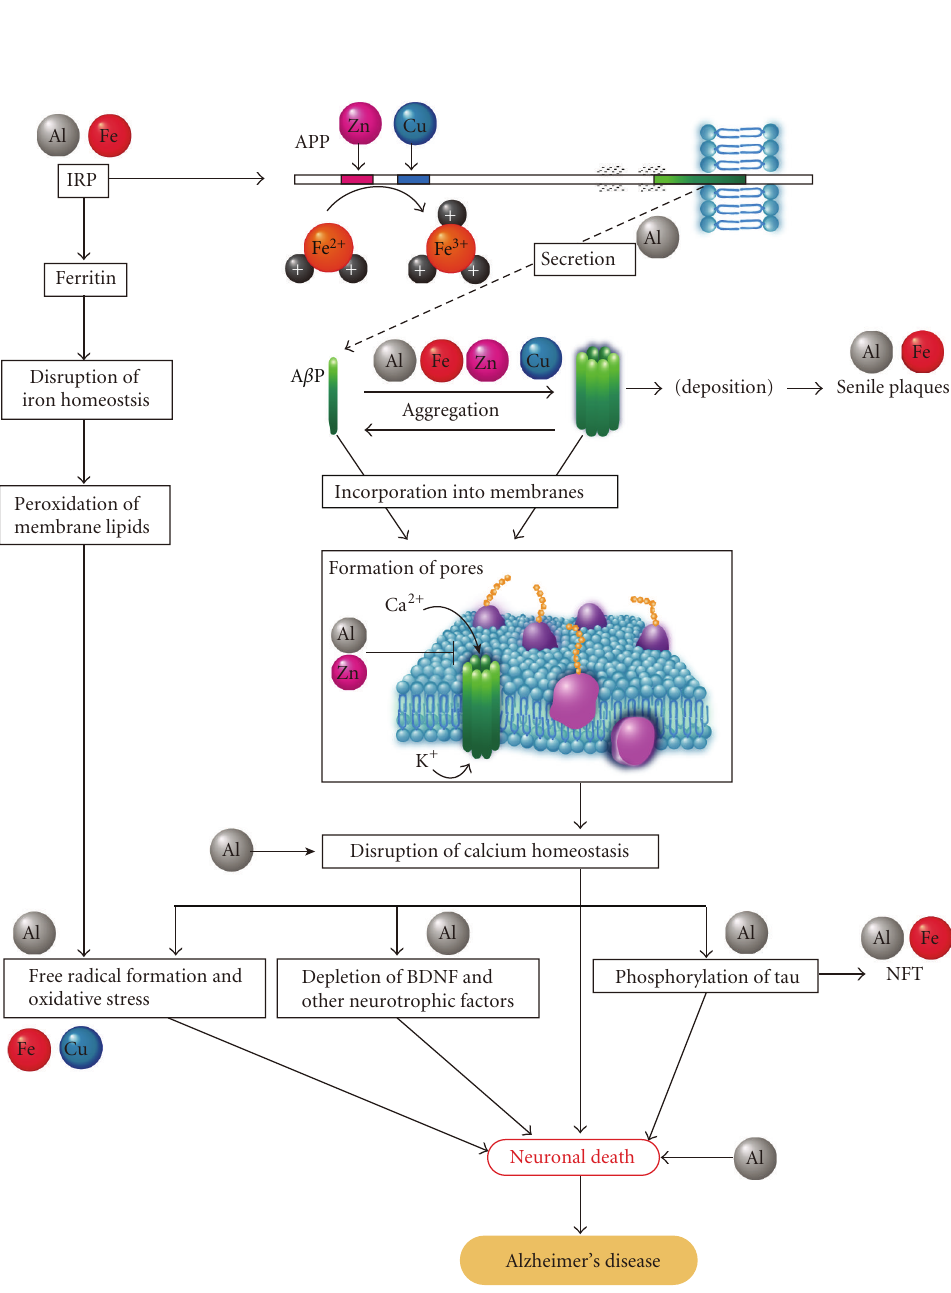
Figure 5: Modified aluminum hypothesis addressing the implications of Al and other trace metals in the pathogenesis of Alzheimer’s disease. This model describes the implication of Al and other trace metals including Fe, Cu, and Zn in APP processing, generation and oligomerization of A β P, and the neurotoxic e ff ects caused by A β P. Details are descried in the